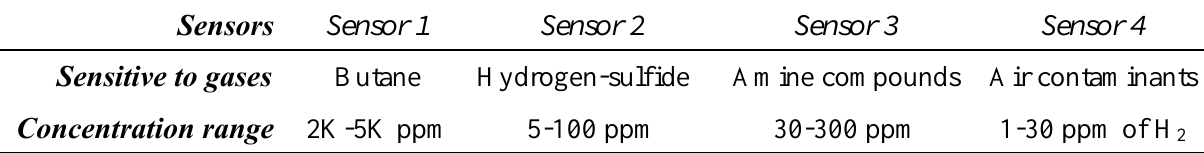
Table 1. Sensors used for the e-nose prototype.